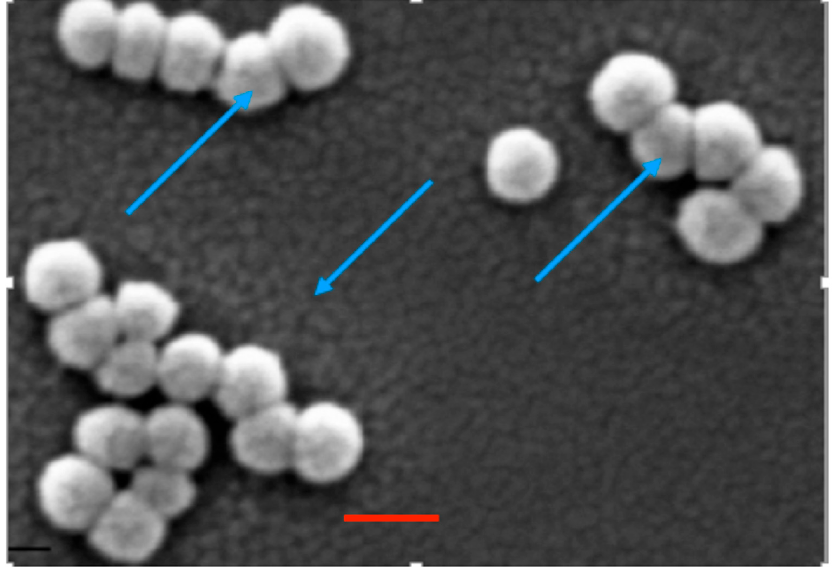
Figure 5. Nanoparticles of SiO 2 (220 nm in size) onto which C 18 OH was adsorbed. NP s were dissolved in EtOH, reacted, dried, repeatedly washed in organic solvents, and kept in DMF until use. NP s stickiness, when they are left on air for some hours, is evident, as indicated by blue arrows. The inter-particle regions have strong similarity with details met when cells join together, or there is mitosis during the partition in two daughter cells. The red bar size is 300 nm long. For more details, see Ref.